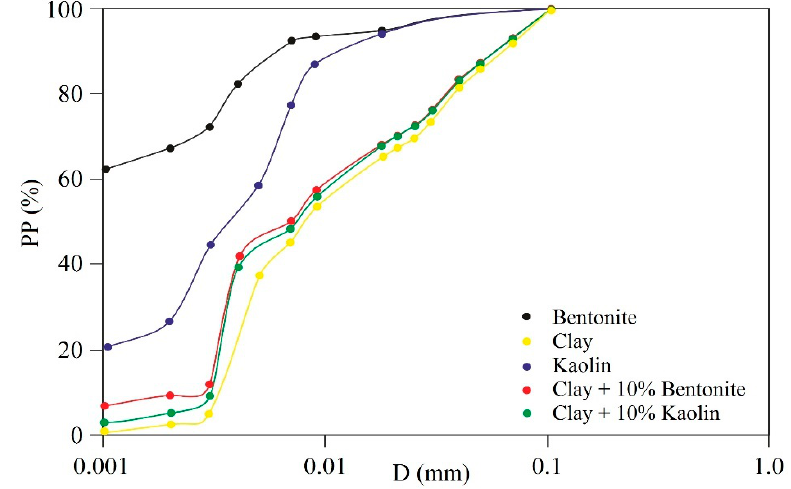
Figure 1. Results of the particle ‐ size distribution for t he studied soils from the hydrometer test.